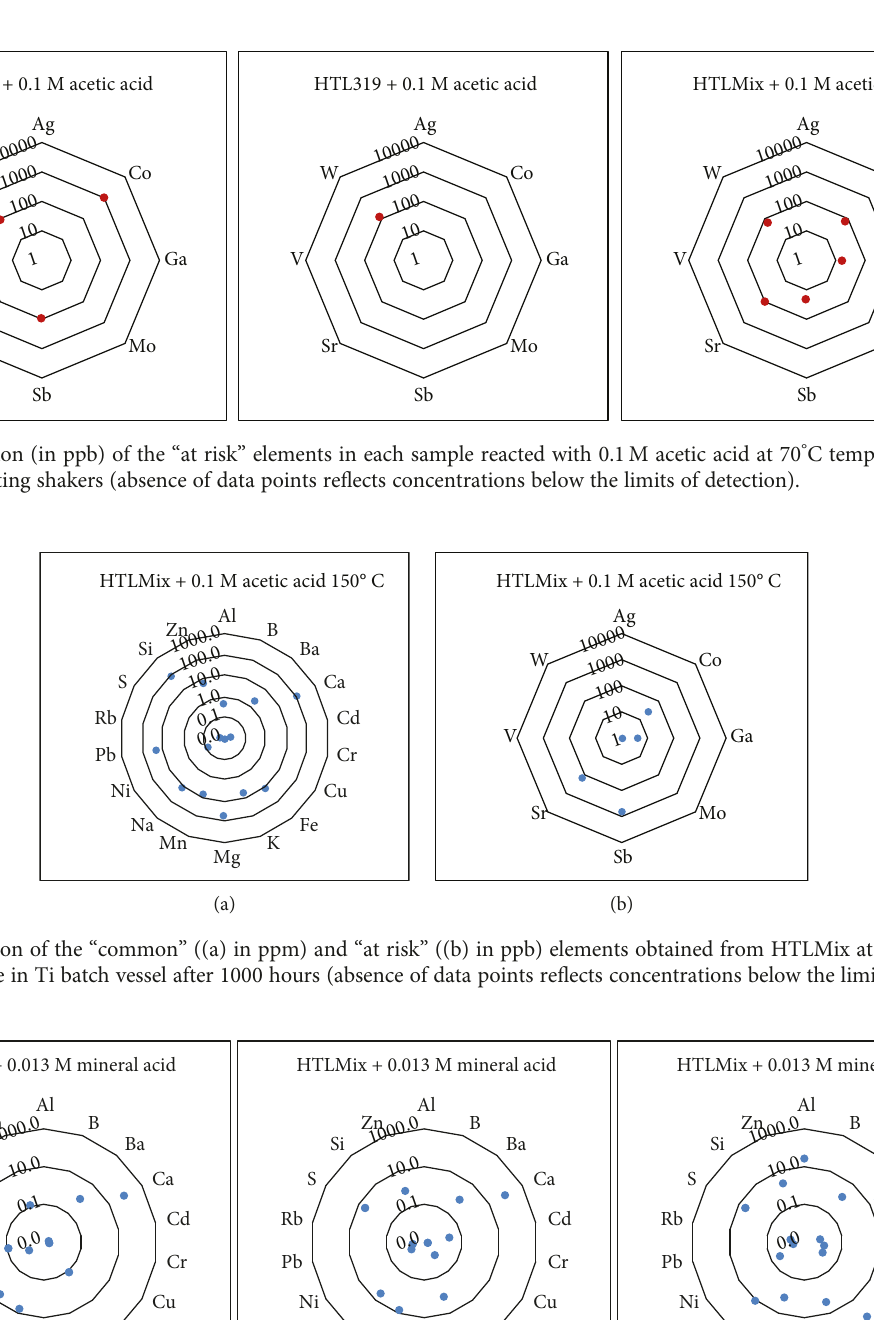
at 100 ° C temperature 3